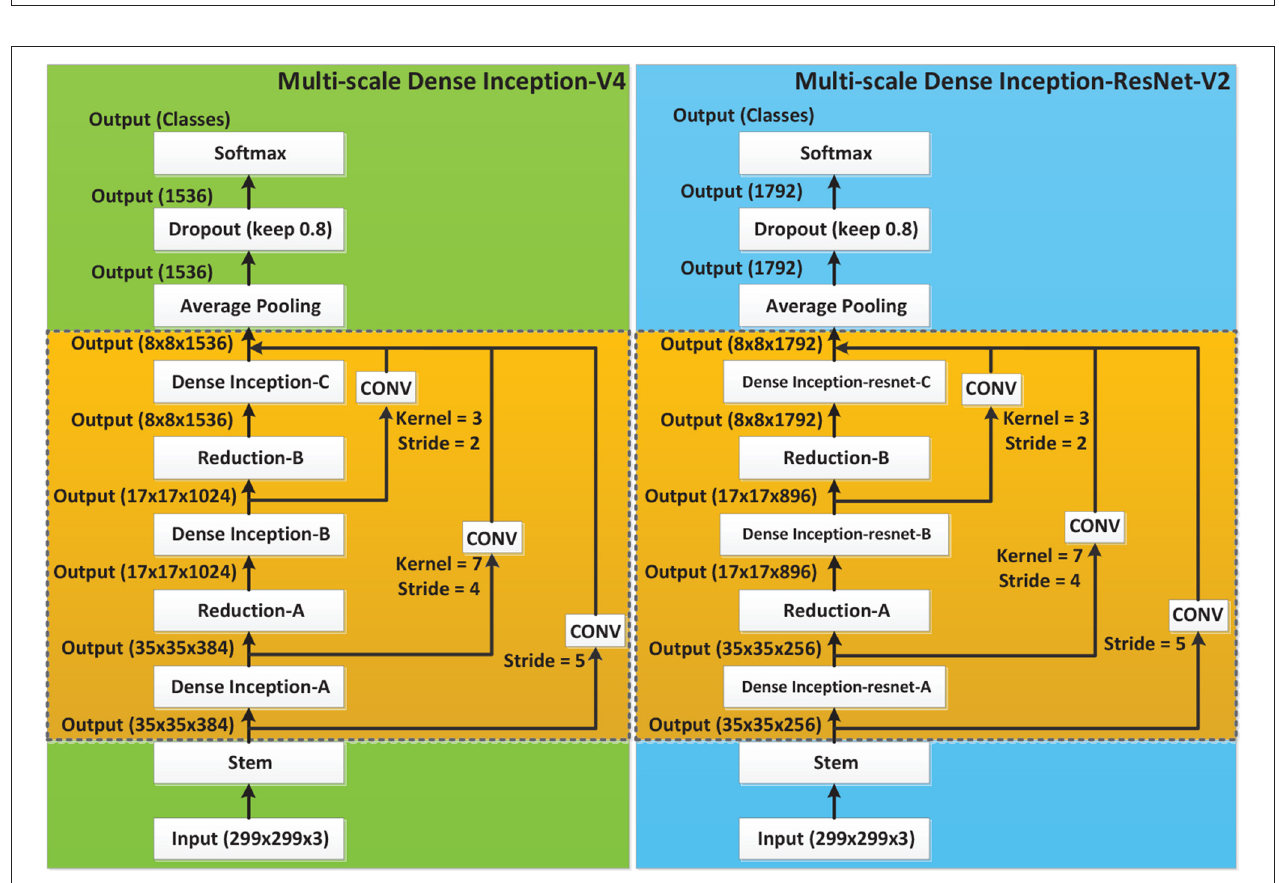
FIGURE 6 | Multi-scale Dense neural